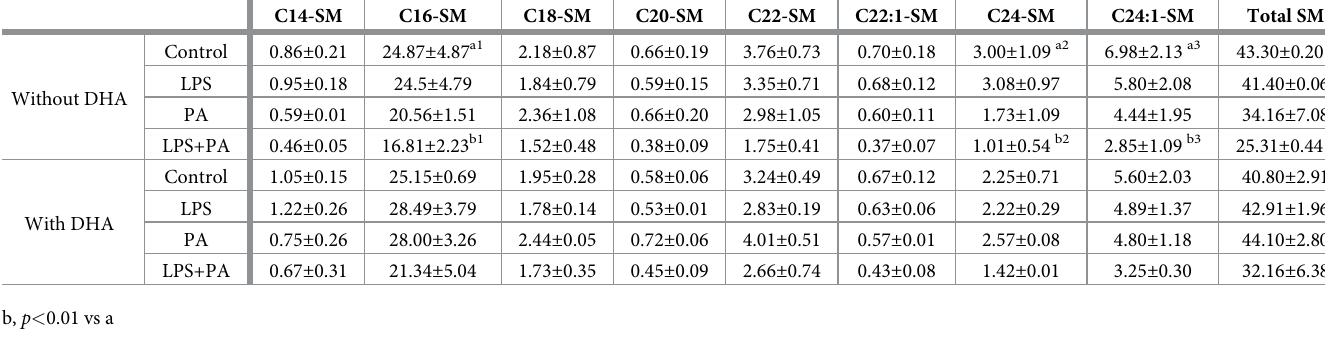
Table 3. The effect of DHA on sphingomyelin content regulated by LPS, PA or LPS plus